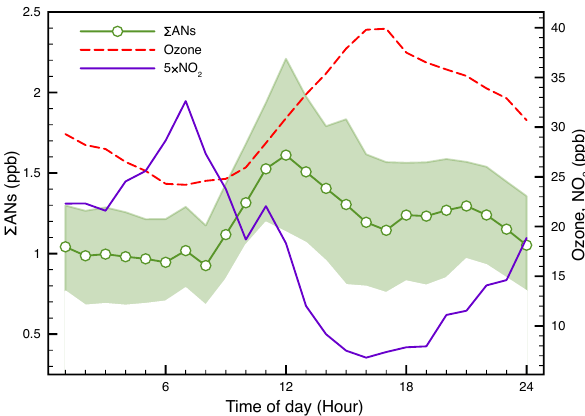
Figure 2. Diurnal variations of (cid:54) ANs, ozone, and NO 2 . Lines rep- resent median values while the shaded area of (cid:54) ANs represents the interquartile (25–75%) coverage. The (cid:54) AN data have been cor- rected for O 3 interference and the ClNO 2 contribution has been subtracted (see